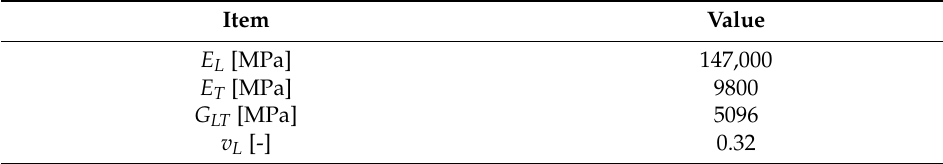
Table 2. Material properties of unidirectional pre-preg tape.